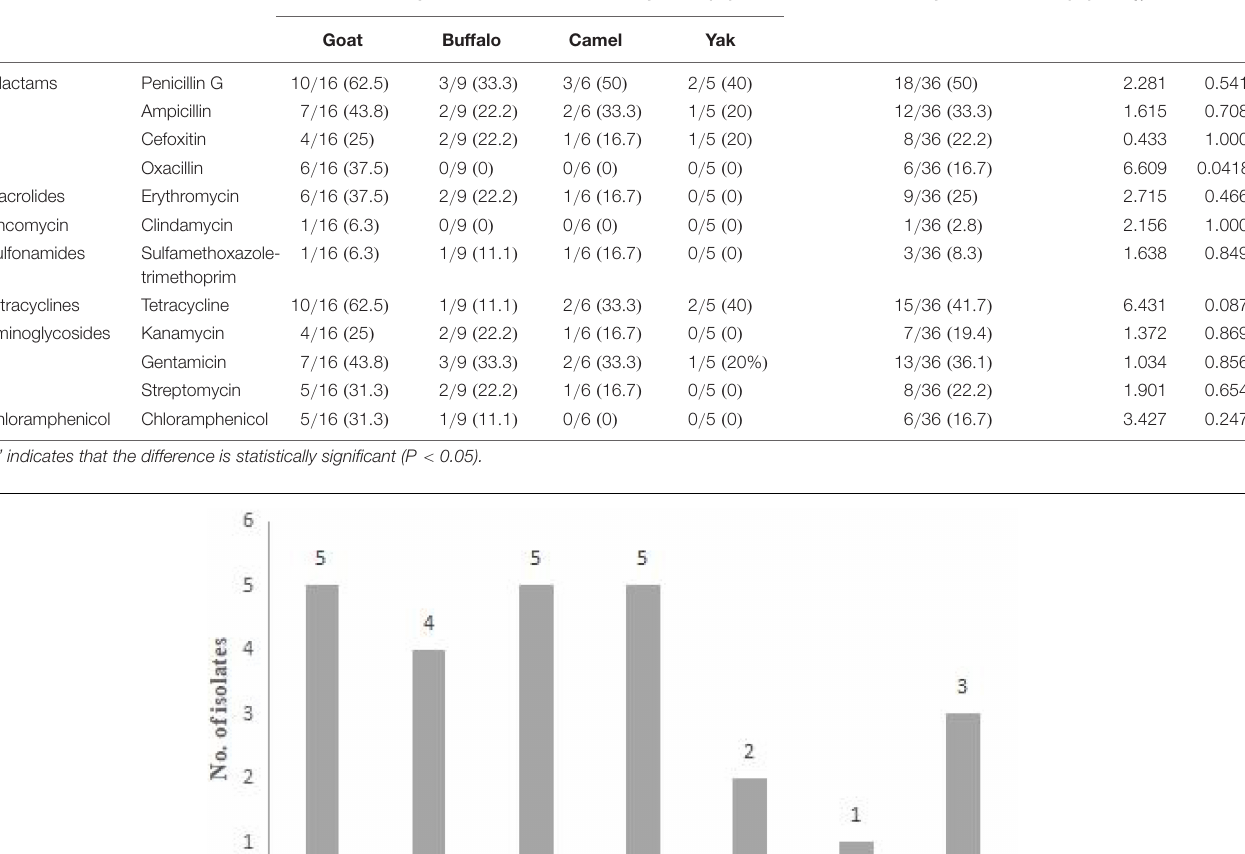
TABLE 1 | Antibiotic resistance of Staphylococcus aureus strains isolated from different raw milks. Antibiotic class Antibiotic Number of positive strains for animal species (%) Total number of positive strains (%) χ 2 P Goat Buffalo Camel Yak